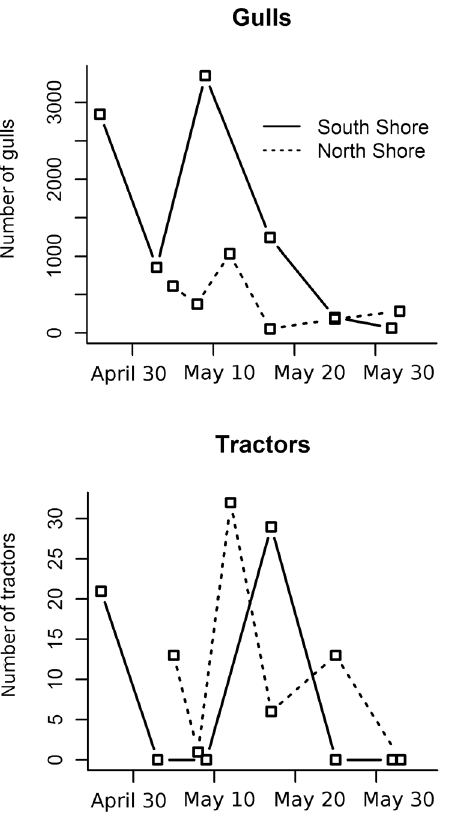
Figure 3. Use of agricultural lands by breeding Ring-billed gulls. Number of gulls and of tractors observed during surveys on the North and South shores of the St. Lawrence River, 2010.